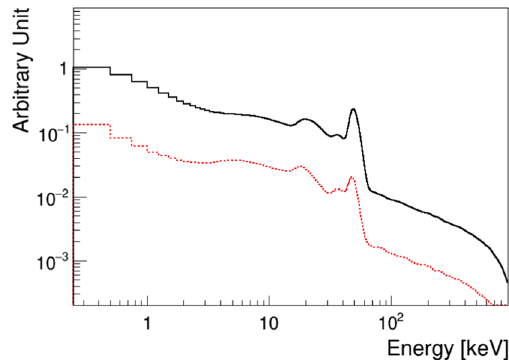
Fig. 5 Simulated energy spectra for the beta decays of 210 Pb within the surface of Crystal 7; we simulated the energy spectra for beta decays of 210 Pb that are exponentially distributed in the surface of Crystal 7 by following two exponential functions with mean depths of 1.39 µ m (black solid line) and 0.107 µ m (red dashed